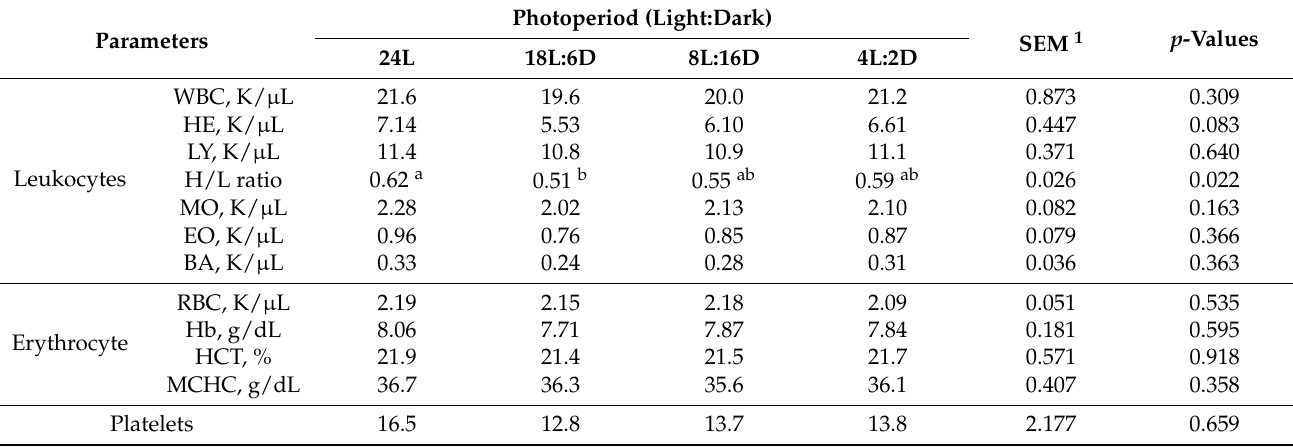
Table 3. Effect of photoperiod on leukocyte, erythrocyte, and platelet profiles of